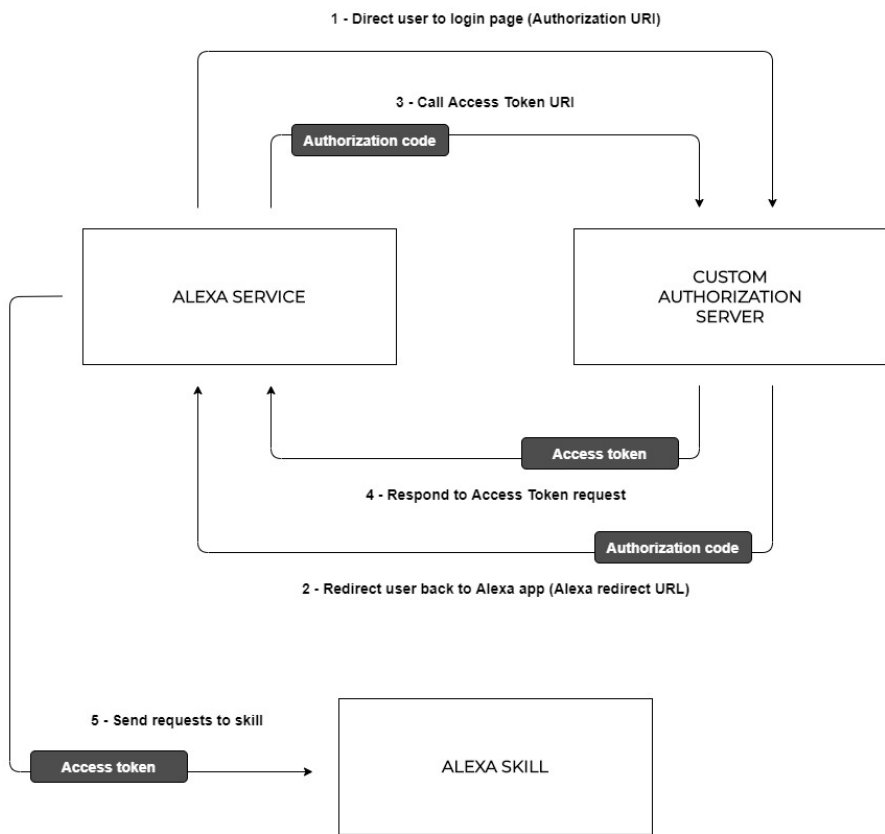
Figure 5. Account Linking flow for authorization code grant type (Source: own authors’ elaboration).